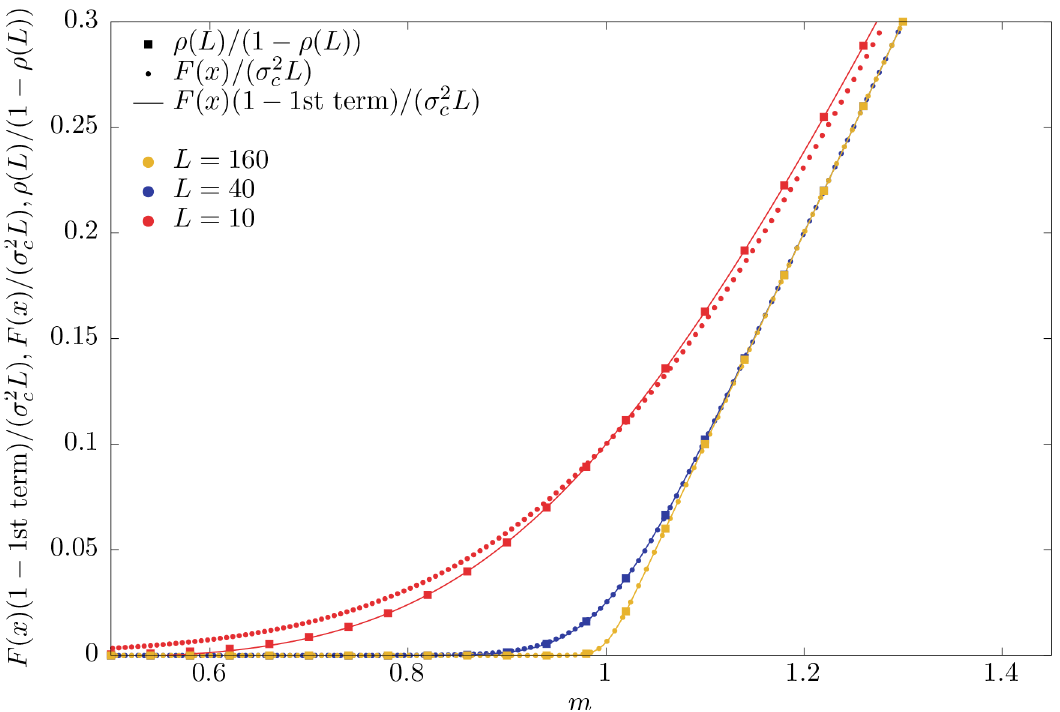
Fig 2. Same as Fig 1a, but replacing the order parameter ρ ( L ) by ρ ( L )/[1 − ρ ( L )]. The exact behavior is given by Eq (41), and the scaling law with the first correction to scaling is given by Eq (45). It becomes clear how the performance of the finite-size scaling law is even better than for ρ ( L ), in particular for m > 1. The program used to draw the figure is provided as S1